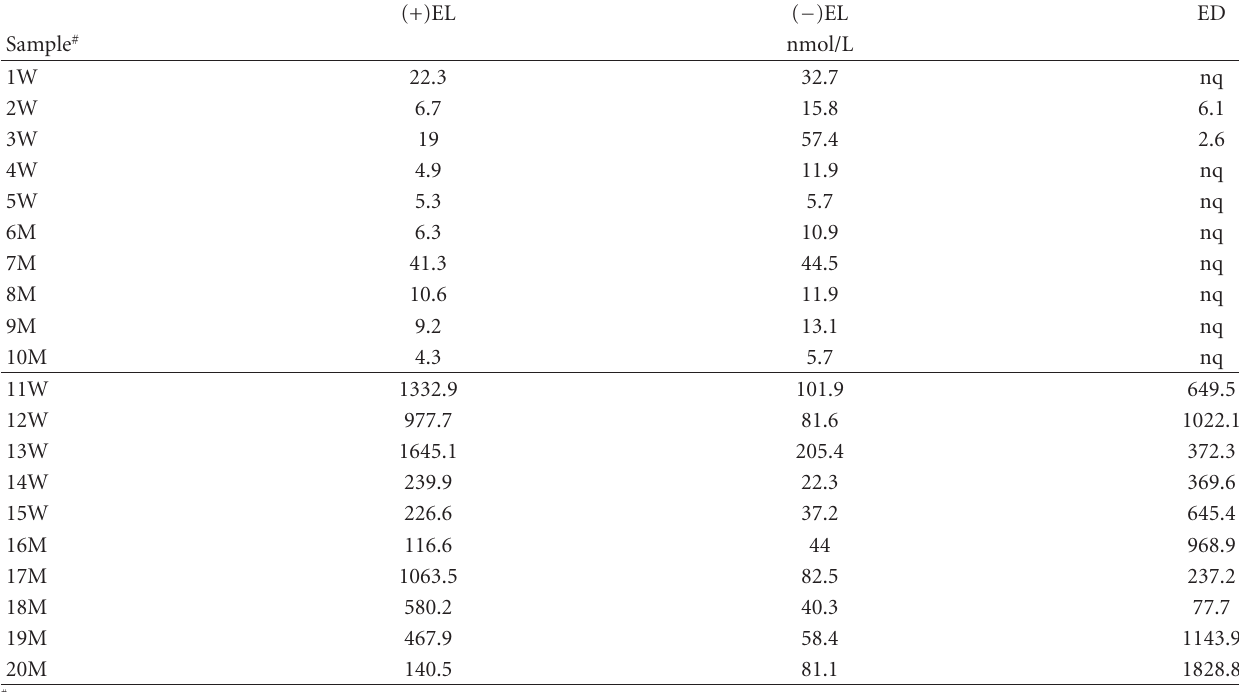
Table 1: Concentrations of enterolactone (EL) enantiomers and enterodiol (ED) in human serum samples collected before and after flaxseed supplementation.